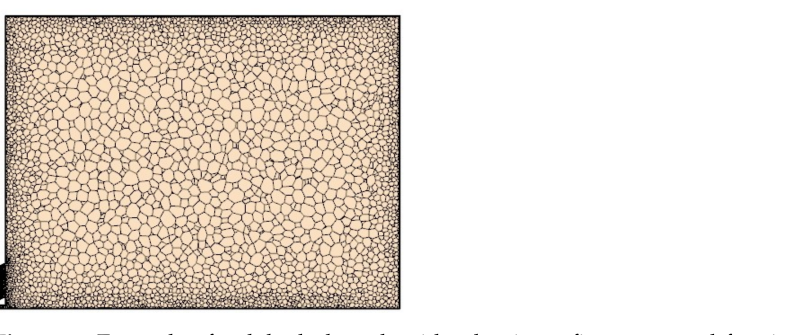
Figure 5. Example of polyhedral mesh with adaptive refinement used for simulations (detailed lateral view).